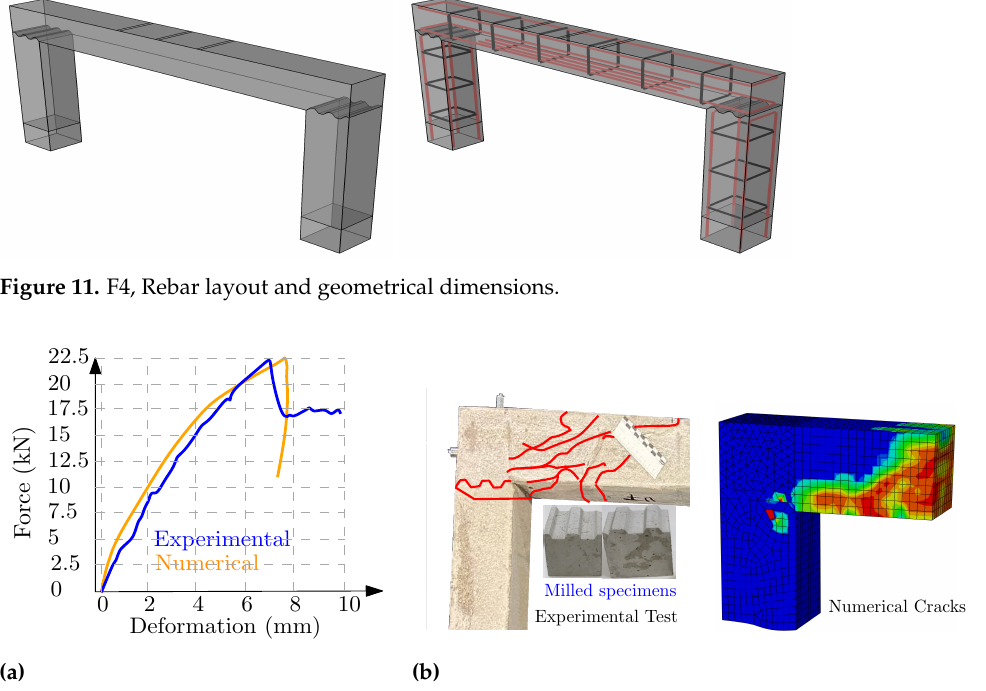
Figure 12. F4, ( a ) Force–deformation, ( b ) experimental cracking and numerical cracking